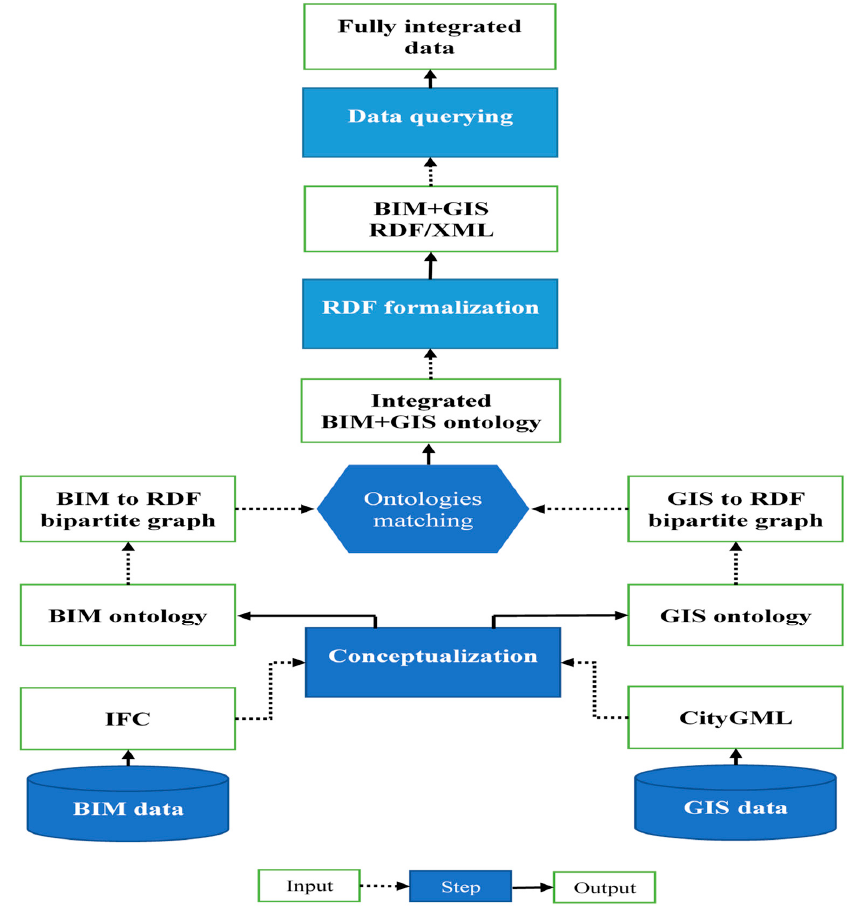
Figure 6. The BIM and GIS integration process.